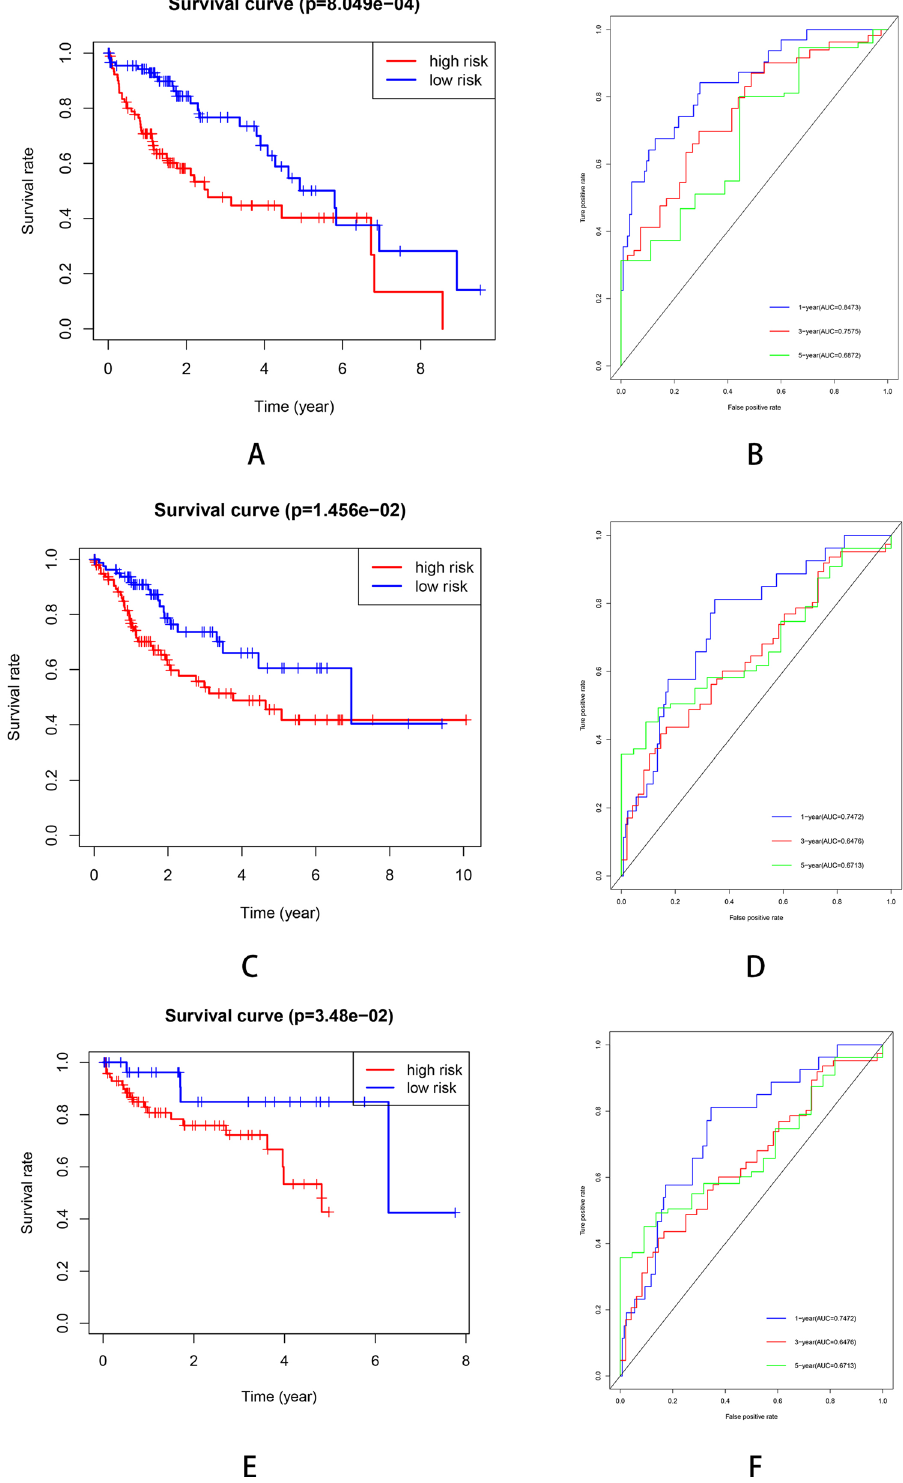
Figure 5. (A) Kaplan–Meier plots of TCGA training cohort. (B) ROC curve for the TCGA training cohort. (C) Kaplan–Meier plots curve of TCGA testing cohort. (D) ROC curve for the TCGA testing cohort. (E) Kaplan– Meier plots curve of GSE cohort. (F) ROC curve for the GSE